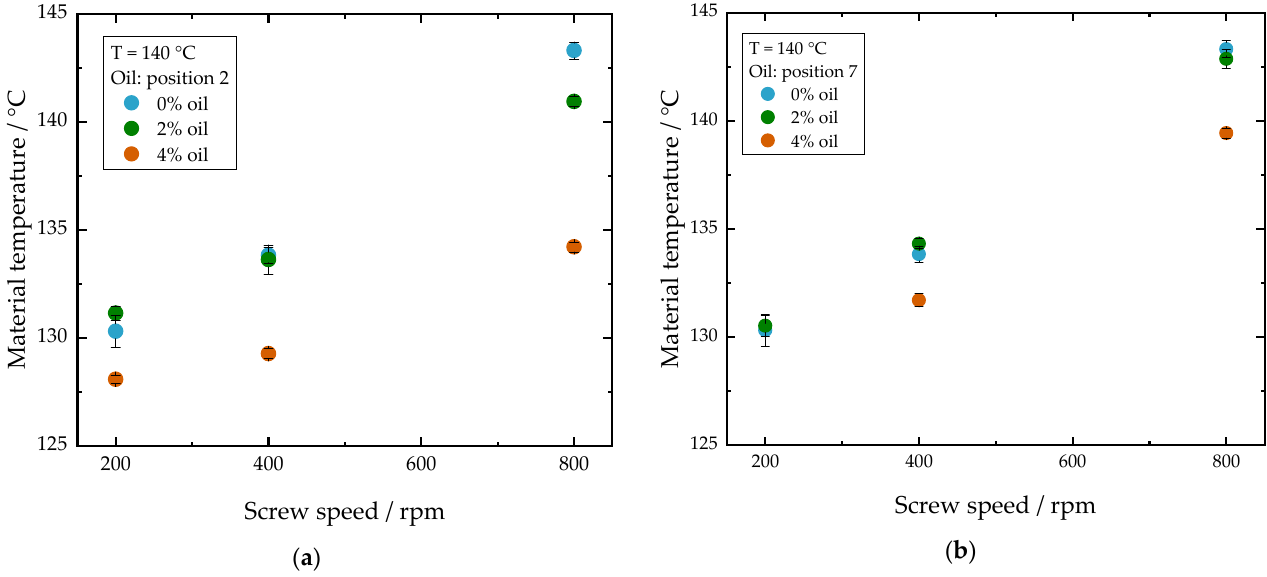
Figure 5. Influence of screw speed on material temperature for oil addition at ( a ) position 2 and ( b ) position 7 for different oil contents. Total mass flow was 10 kg/h and water content was 51–53% for all samples.